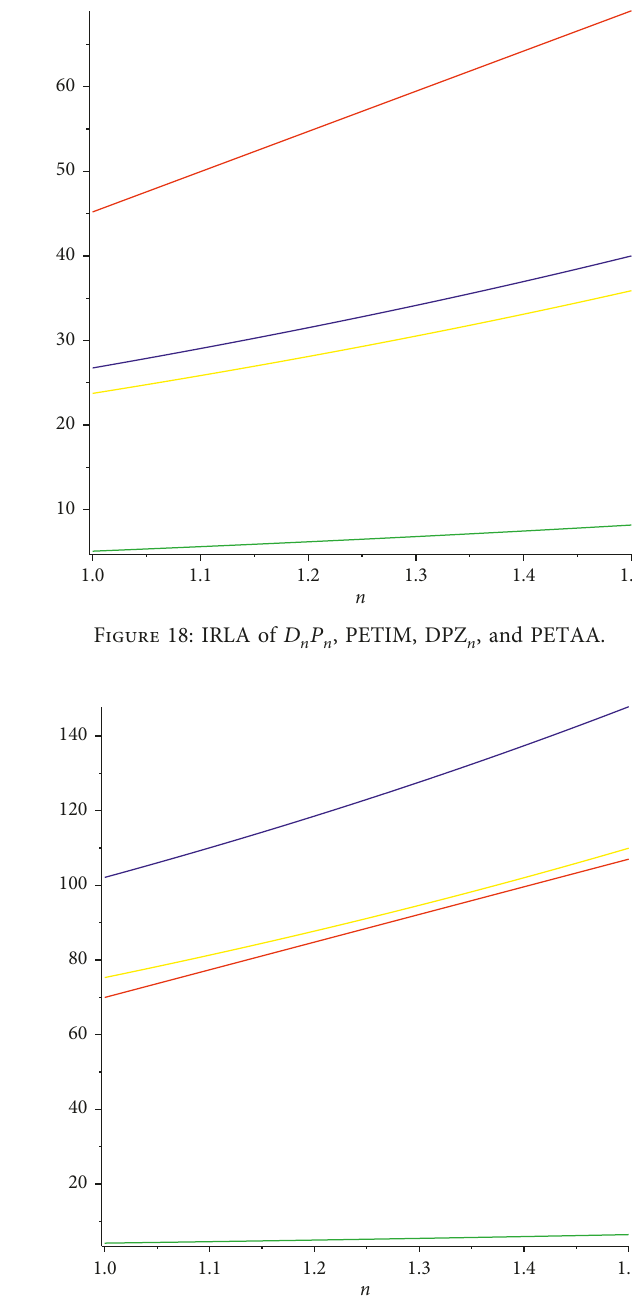
P n n , PETIM, DPZ n , and PETAA.